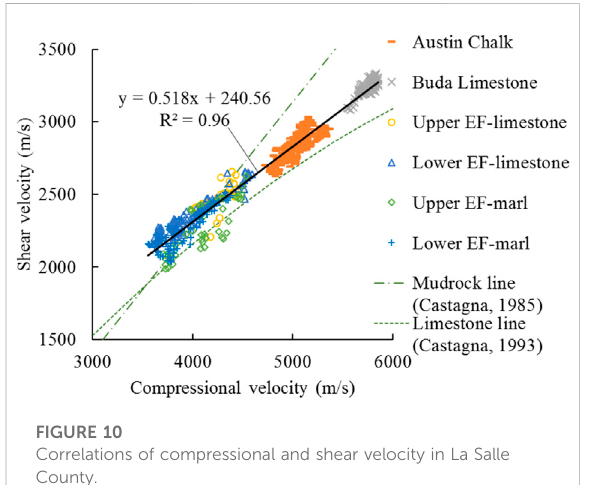
FIGURE 11 Correlations of compressional velocity and gamma ray in different layers.